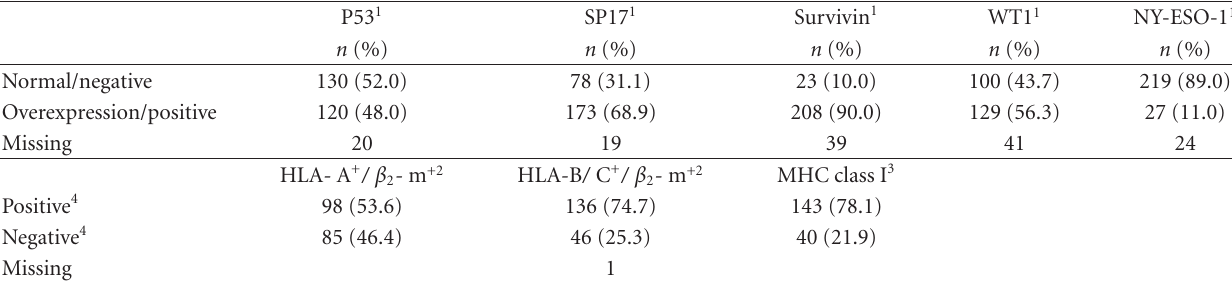
Table 3: Expression levels of antigen and MHC class I components.